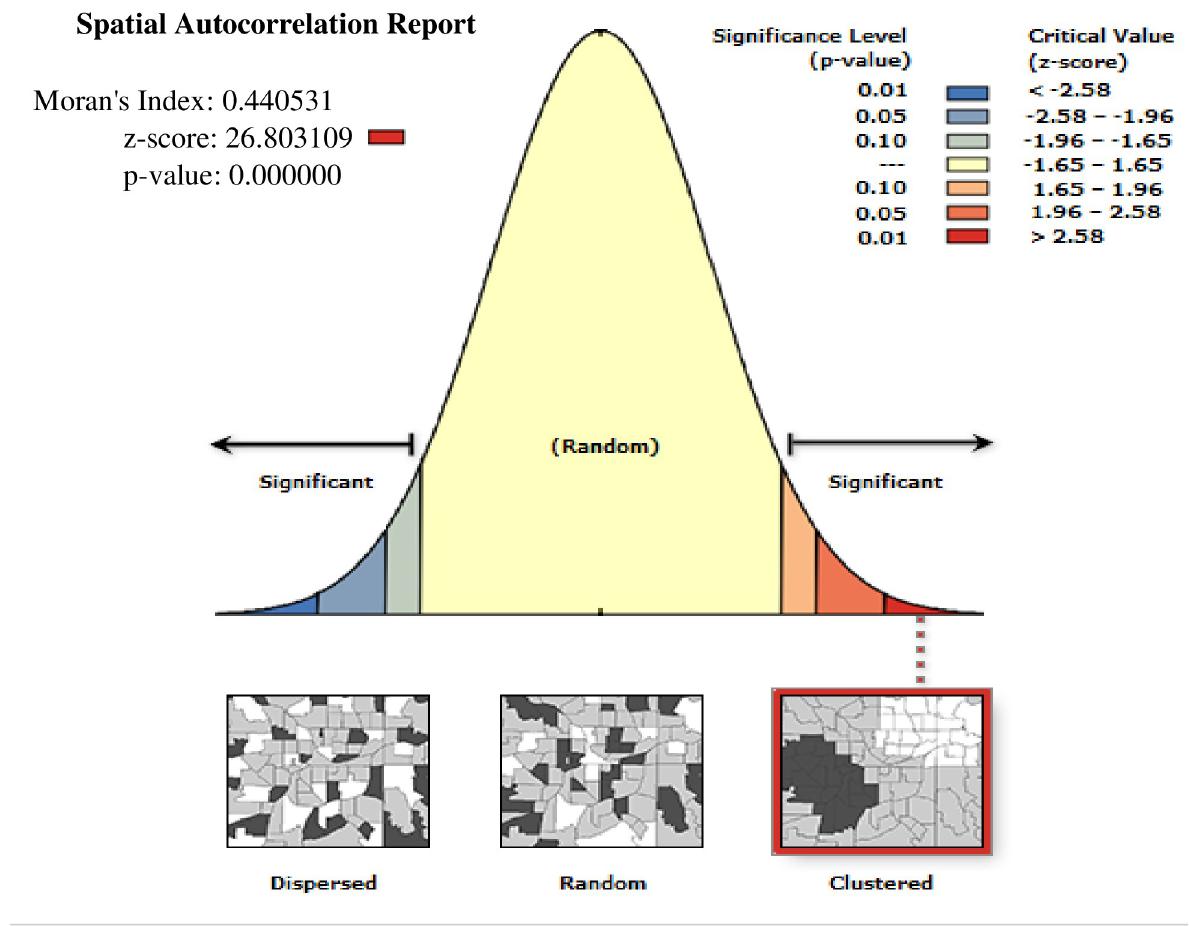
Fig 4. Spatial autocorrelation of open defecation usage among households in Ethiopia, EDHS 2016 plotted using ArcMap 10.7.